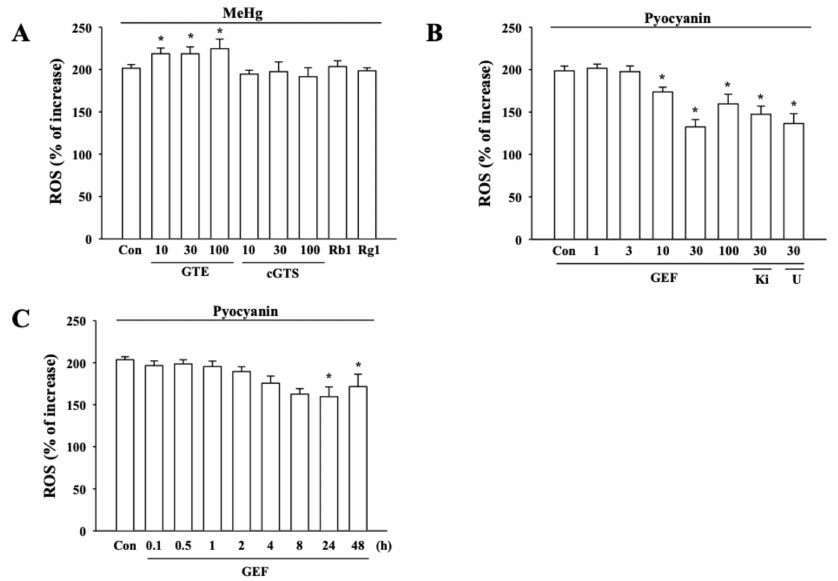
Figure4. E ff ectsofGEForotherginsengcomponentsonMeHg-andpyocyanin-inducedROSgeneration. ( A ) Ginseng total extract (GTE), crude ginseng total saponin (cGTS) fraction, and ginsenoside Rb1 and Rg1 (30 µ M each) had no e ff ect on MeHg-induced ROS formation. ( B ) E ff ects of GEF on the pyocyanin-induced ROS generation. Hippocampal NPCs were incubated pyocyanin (30 µ M) with the control vehicle (Control) or various concentrations of GEF. GEF decreased ROS generation in a concentration-dependent manner. The indicated concentration of GEF was pretreated 16 h before pyocyanin and the degree of cell survival rate was measured as described in Methods. LPA 1 / 3 receptor antagonist (Ki16425, 10 µ M) or phospholipase C inhibitor (U73122, 5 µ M) was used. ( C ) GEF-mediated ROS decrease was time-dependent. Cells were treated with 30 µ g / ml GEF and subjected to WST-1 assay as described in the Materials and Methods section. Data are presented as the mean ± SEM (n = 6; * p < 0.01, compared with untreated controls). Cells were treated with indicated concentrations and subjected to WST-1 assay as described in the Materials and Methods section. Data are presented as the mean ± SEM (n = 6; * p < 0.01, compared with untreated